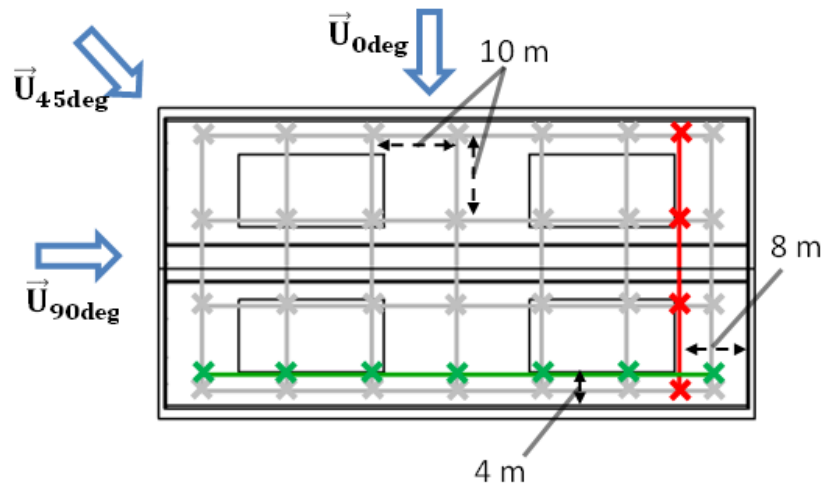
Figure 6. Design of the net and lines of points for the concentration evaluations. The mixing gas concentration ratios M net = (cid:16) (cid:17) C NH / C CO were evaluated as the mean concentration of NH 3 over the net (grey) 3 2 line points or over the lines (green and red) points divided by the mean concentration of CO 2 over the net or line points. The considered line points depended on the air inflow direction. For the airflow in the 0 deg direction, M line = M green line , only the mean concentrations over the points of the green line were considered. For the airflow in the 90 deg direction, M line = M red line , only the mean concentrations over the points of the red line were con- sidered. For the airflow in the 45 deg direction, M line = M green red lines , we considered the mean concentrations over the points of both the green and red lines. Those ratios were compared with the source gas concentration M source = Thus, we looked for the condition quotient 1 to be